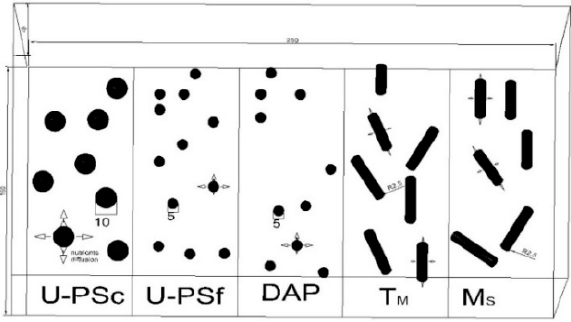
Figure 1. The scheme of incubation boxes with fertilizers (without soil). The experiment was set up in a random system with three replications for each